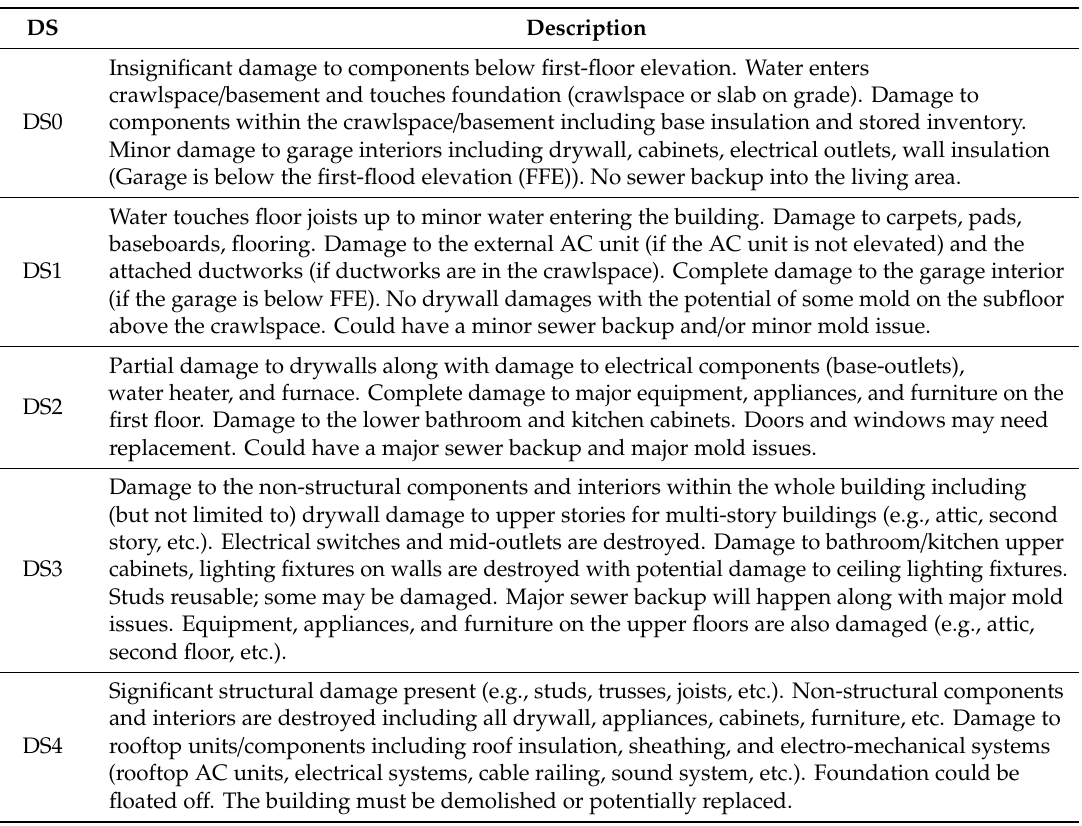
Table 2. Damage states